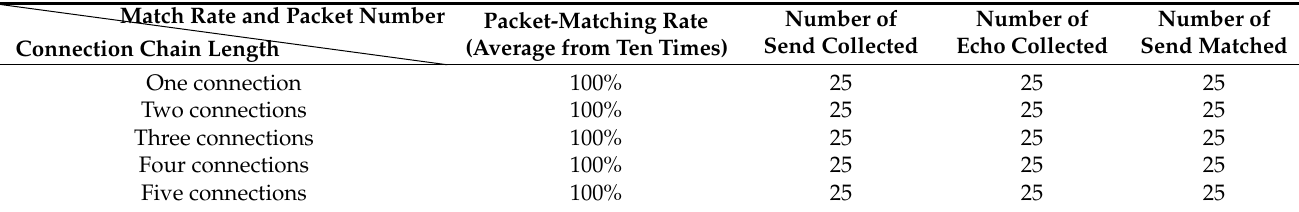
Table 1. Average packet-matching rate of MMD data mining.